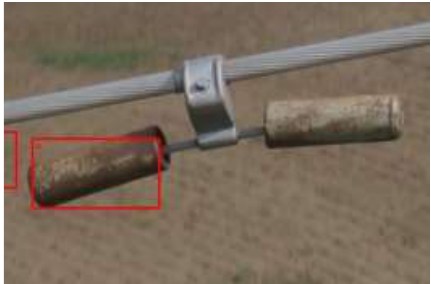
Figure 12. Detection result for components similar to the background obtained using DPM.